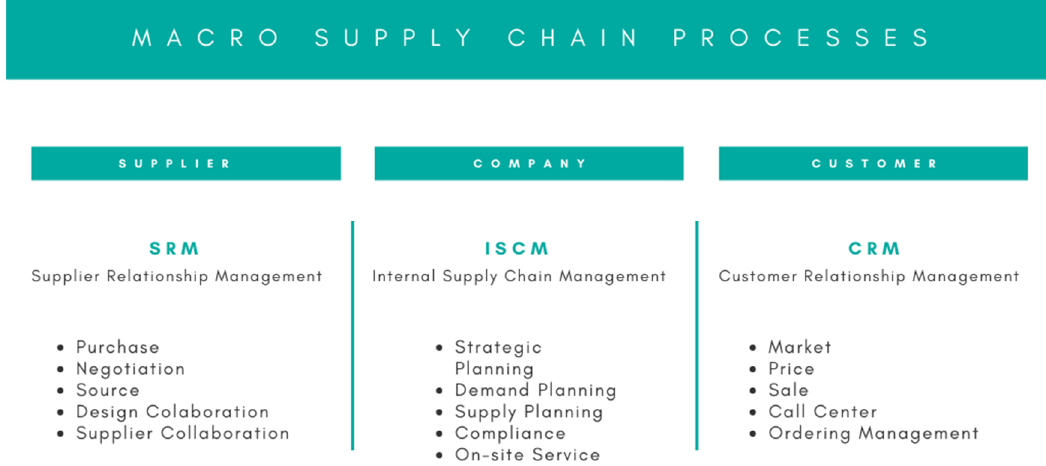
Figure 1. Macro Supply Chain processes adapted from [1].